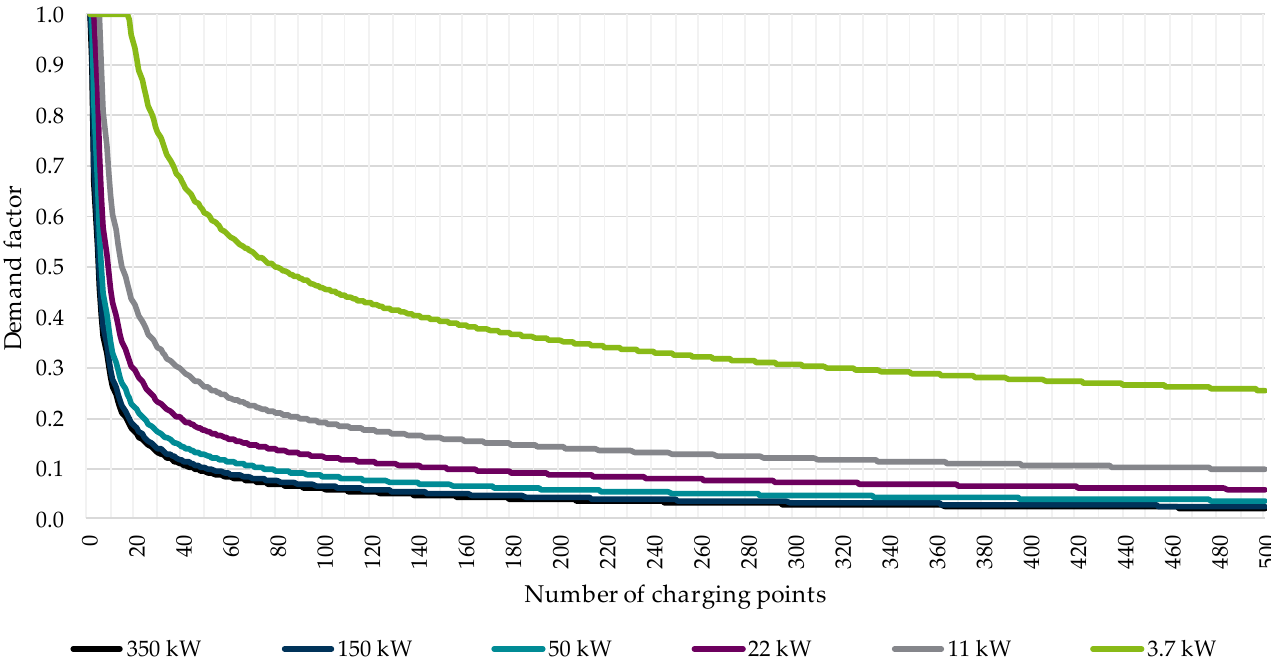
Figure 15. Demand factors (ordinate) for the area type “Rural Region: Central City” and six charging powers.